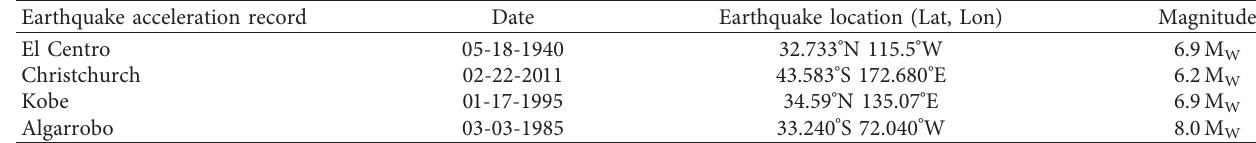
Table 2: Earthquake ground-motions records used in the study.